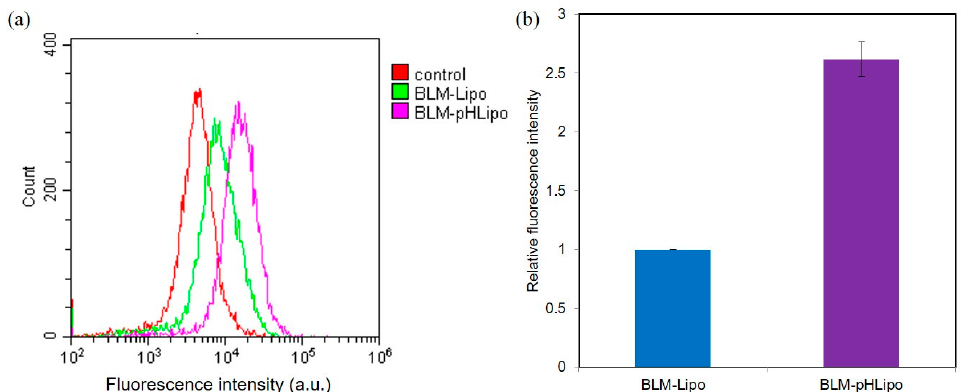
Figure 4. Fluorescence distribution ( a ) and relative fluorescence intensity ( b ) for Colon-26 cells treated with fluorescence dye(DiI)-labeled BLM-Lipo or BLM-pHLipo for 4 h at 37 °C. Lipid concentration was 0.5 mM.